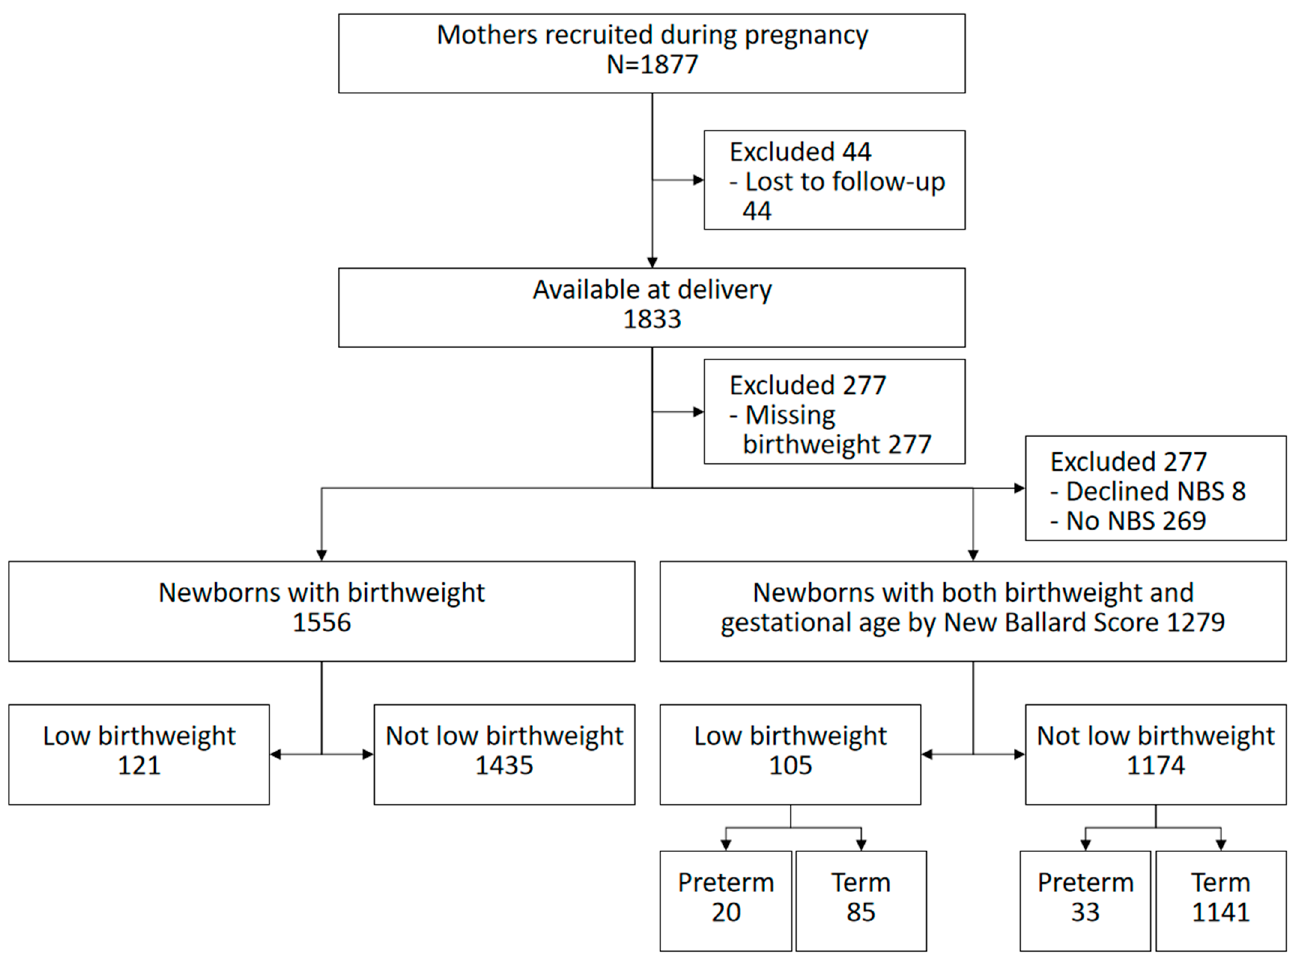
Figure 1. Study profile.